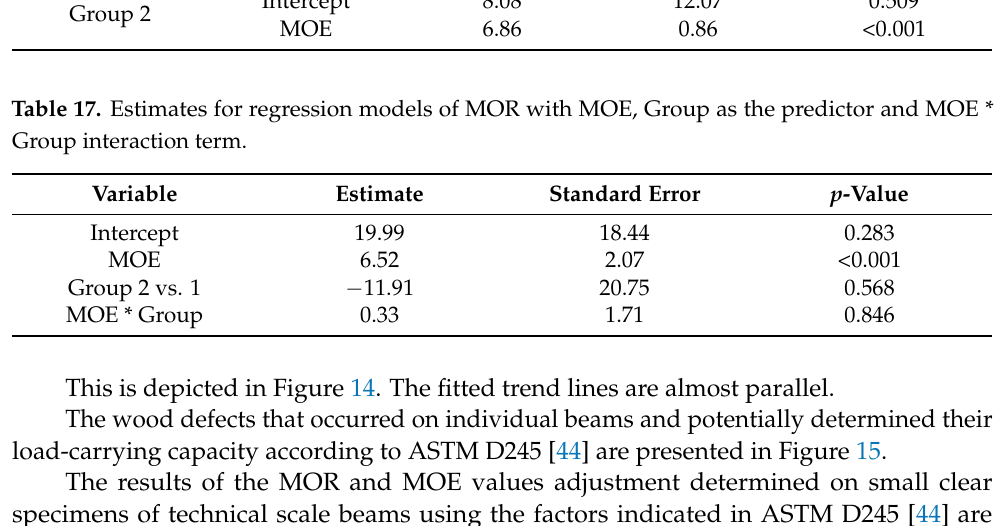
Table 16. Estimates for regression models of MOR vs. MOE for Groups 1 and 2. Group Variable Estimate Standard Error p -Value Group 1